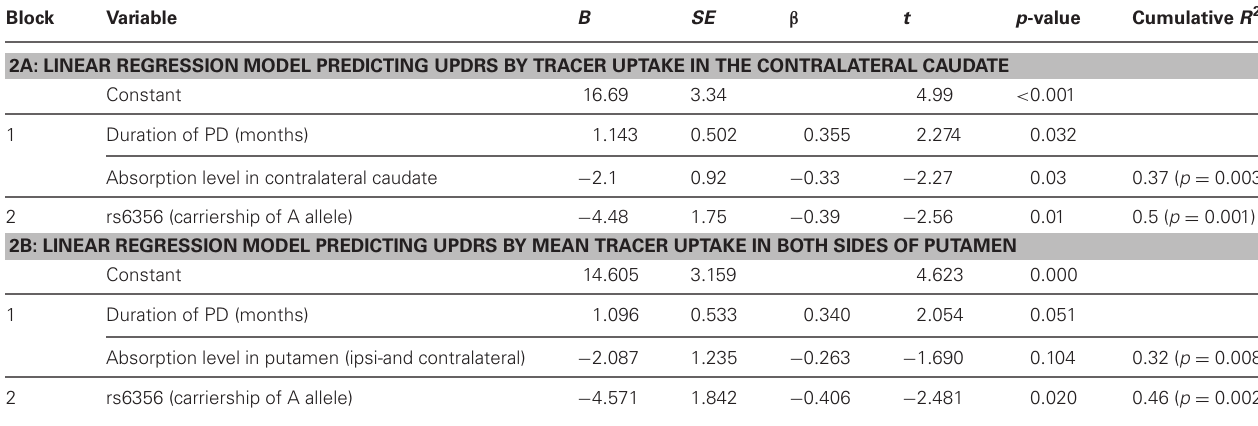
Table A2 | Summary of the linear regression model predicting UPDRS score by model; Block 2 was entered in a stepwise manner. Block